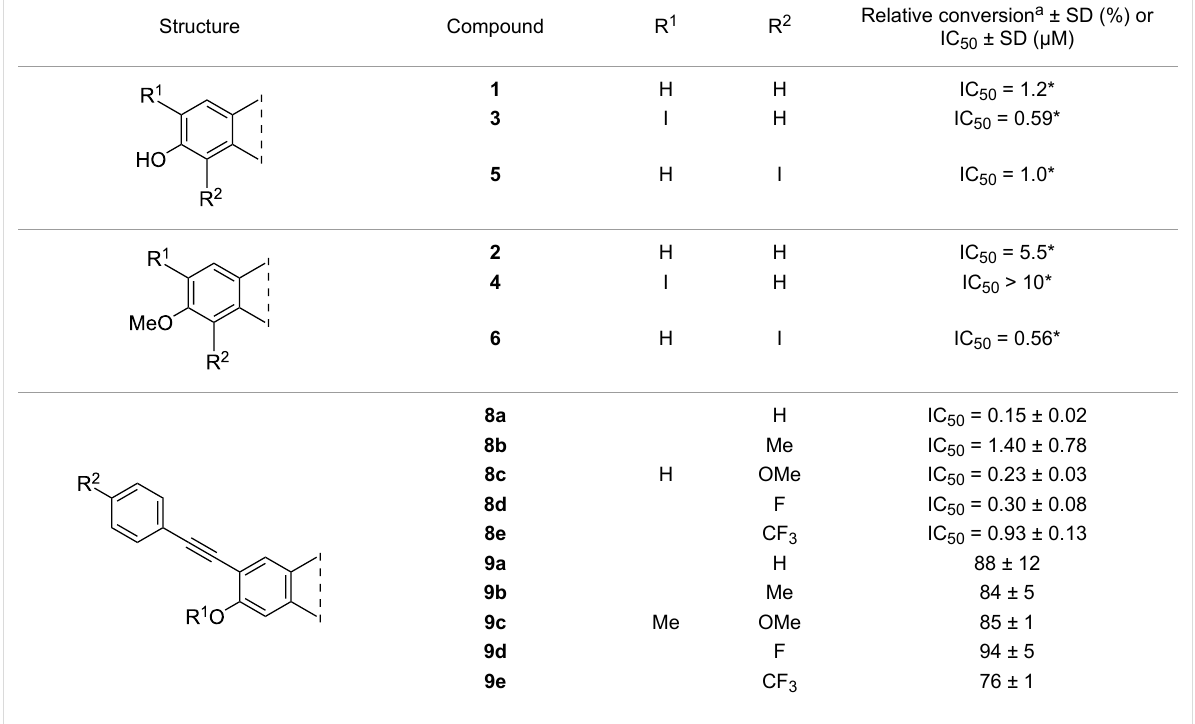
Table 1: 17 β -HSD1 inhibition data of Sonogashira coupled compounds and their precursors ( 1 – 6 ) [12,13] indicated with an asterisk